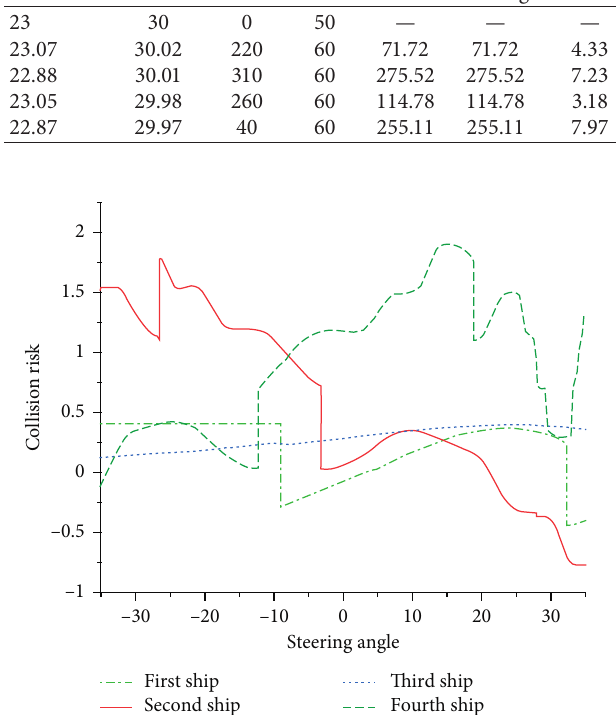
Figure 9: Curve of ship collision